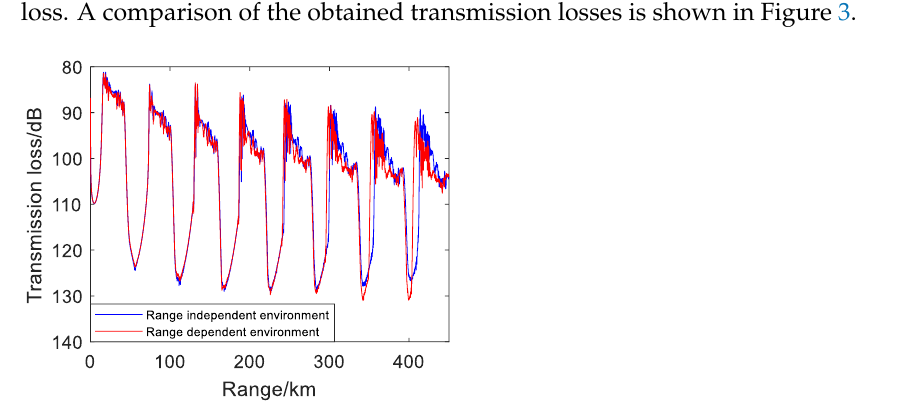
Figure 2. Depth variable function in linear variation case. The transmission loss in the range-independent and range-dependent environments was calculated using the normal and coupled normal modes, respectively. For the range- transfers to other modes, was used. We focused on the position of the convergence zone.